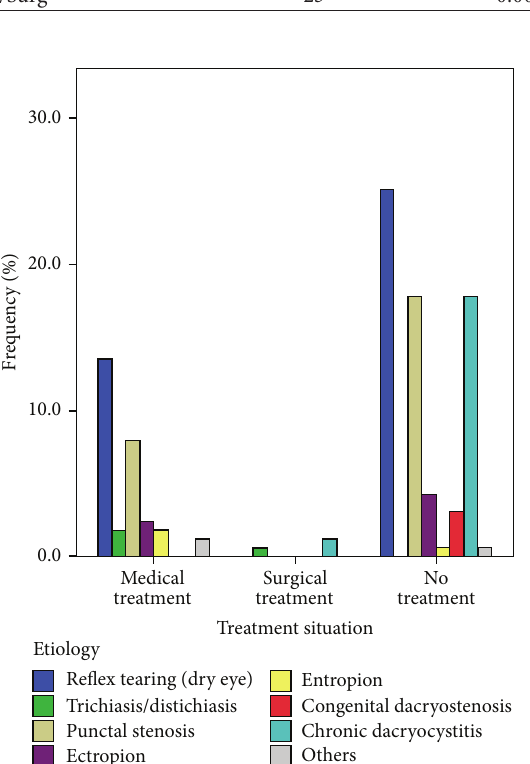
Figure 1: Etiology distribution in different age groups.